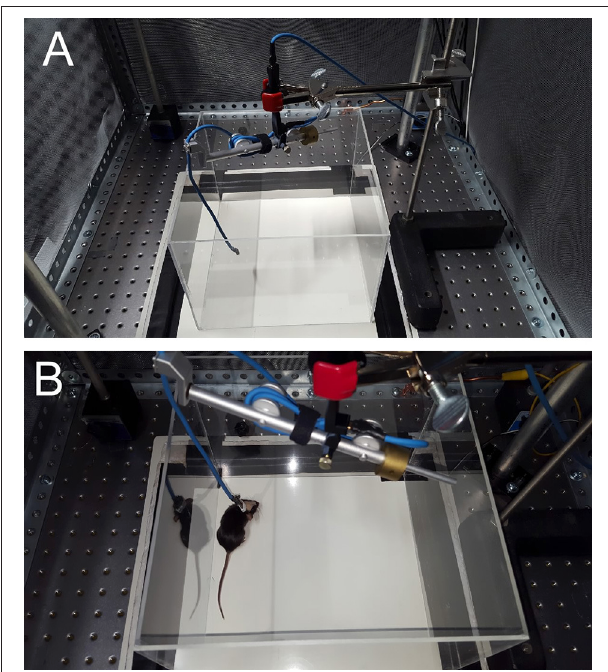
FIGURE 3 | (A) Commutator set-up. (B) Still image of animal in soundbooth.